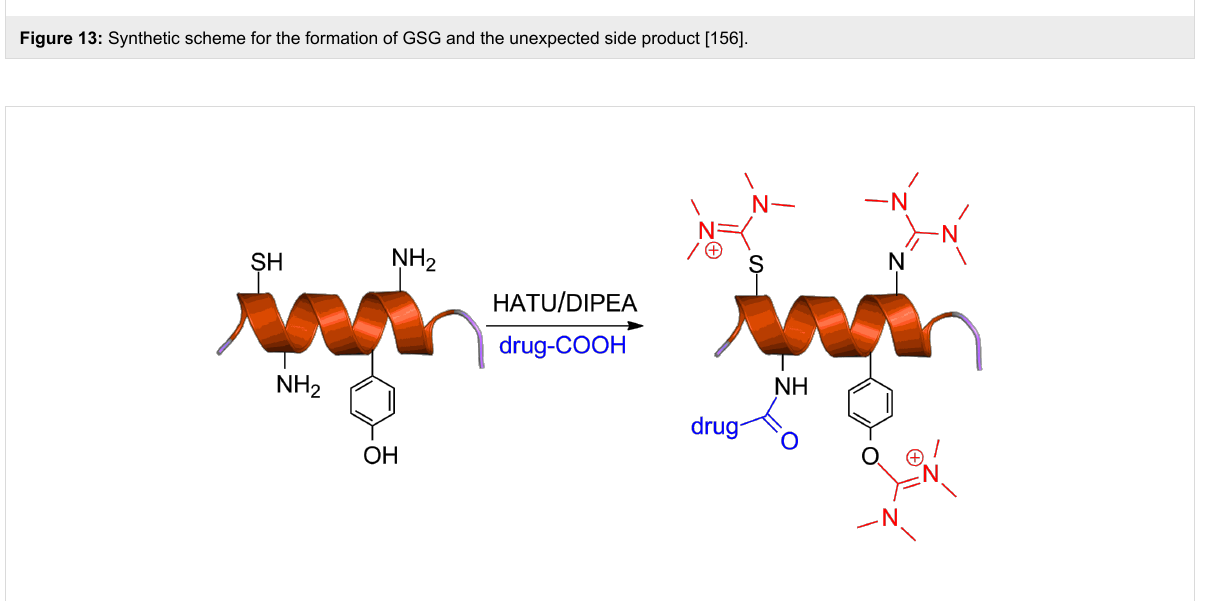
Figure 14: Illustration of uncharted guanidinium peptide coupling reagent side reactions during PDCs synthesis